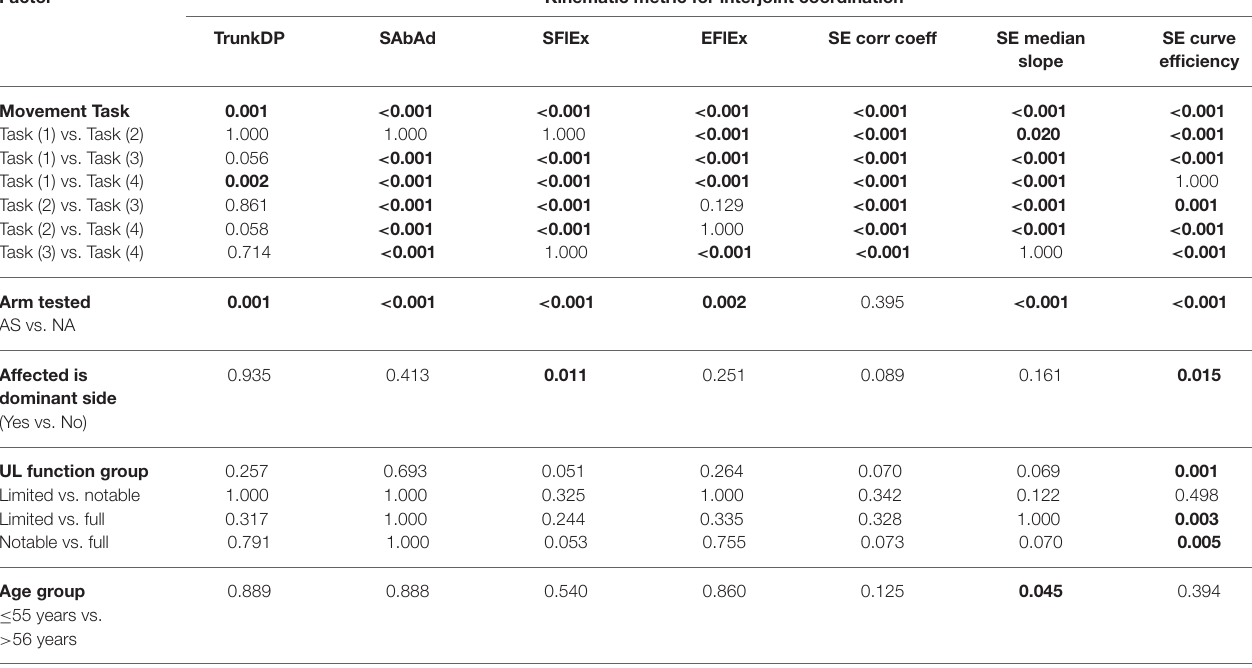
TABLE 4 | Results of linear mixed model analysis. Factor Kinematic metric for interjoint coordination TrunkDP SAbAd SFlEx EFlEx SE corr coeff SE median